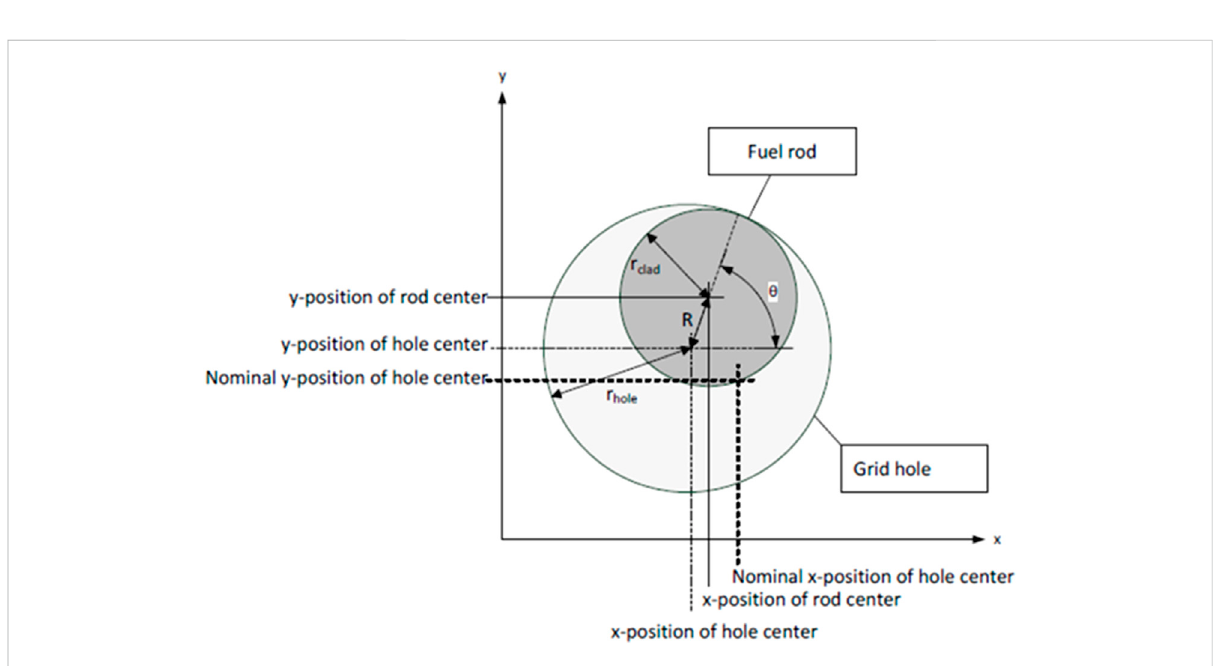
FIGURE 4 Rod location uncertainty: Detail of a rod in its grid